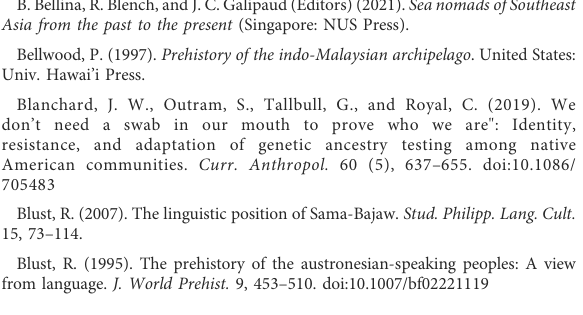
Figure 3. Lastly, we thank the people and local government units of Zamboanga and the Sulu Archipelago for their warm hospitality and